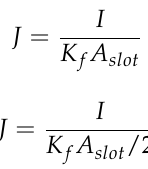
Figure 3. Sub-region division according to the winding configuration: ( a ) whole slot is considered as one region and belongs to one coil, ( b ) whole slot is considered as one region and left side and right side of the slot belongs to different coils, ( c ) whole slot divided into upper and lower sub-regions and each part belongs to one coil.